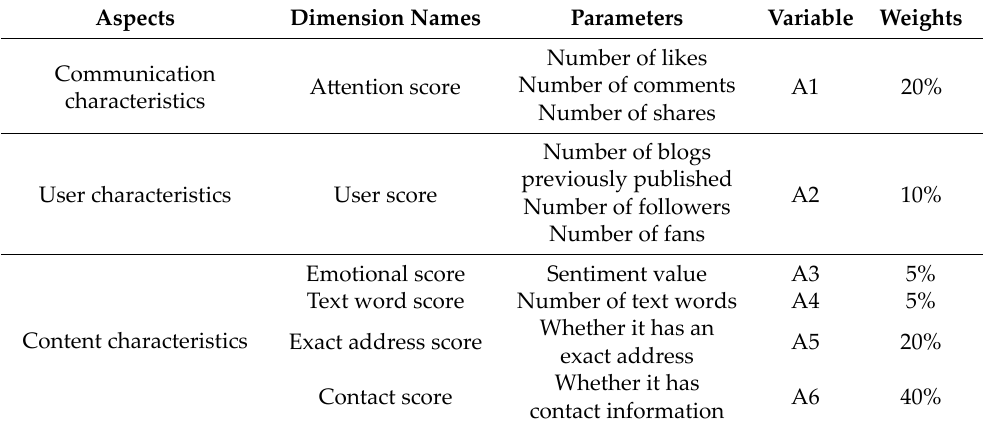
Table 2. Dimensions of judgment rules for microblog